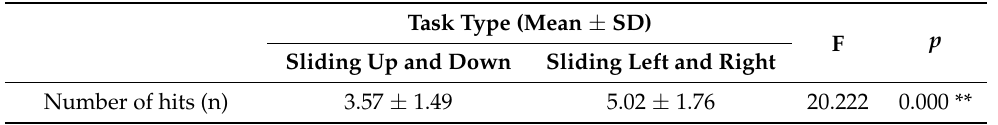
Table 4. Analysis of variance for clicks with different sliding